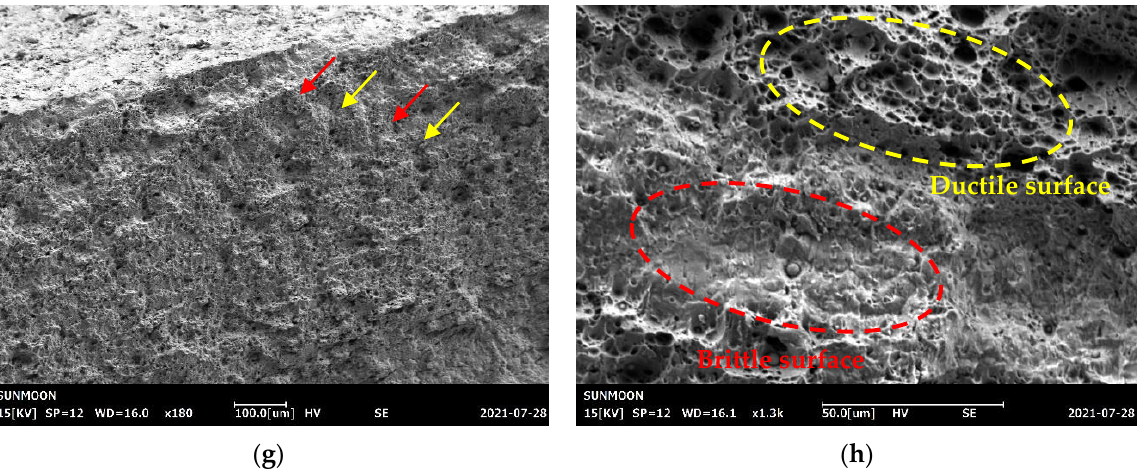
Figure 10. Photographs of the fatigue-fractured overlap-defect specimens. ( a ) Without peening; ( b ) With peening. SEM images of the fracture surface of the peened overlap-defect specimen. ( c ) Overall fracture surface; ( d ) Compressed surface; ( e ) Fatigue striations; ( f ) Progress of crack growth; ( g ) Ductile – brittle surface; ( h ) High-magnification image of the final fracture region.